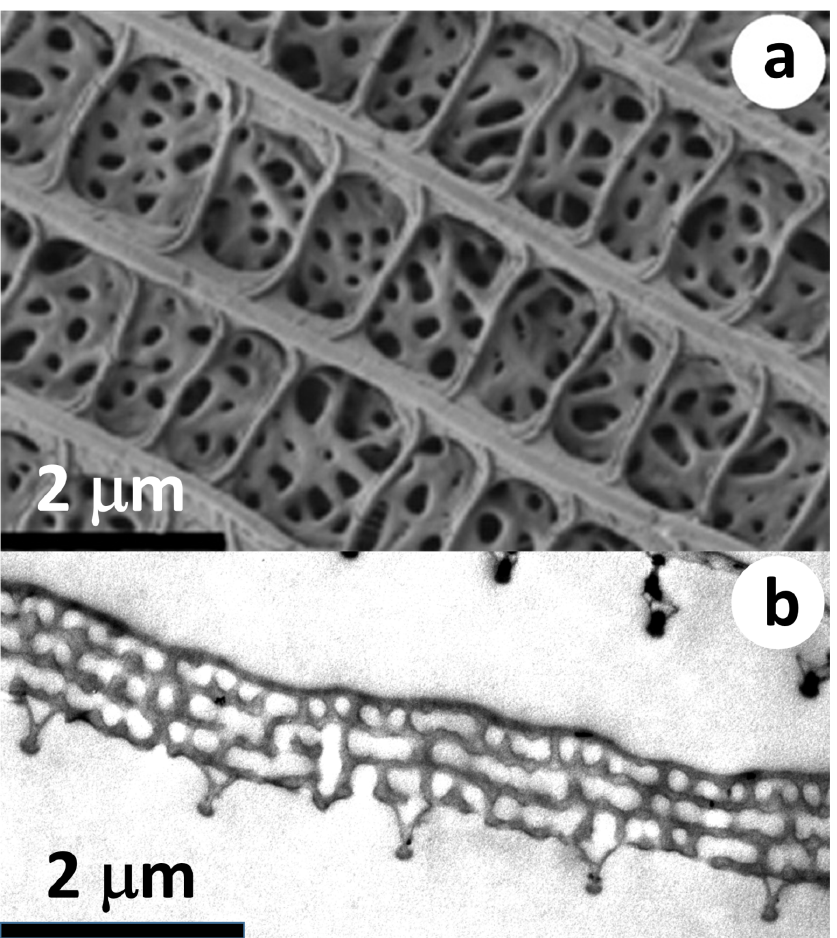
Figure 1. Electron micrographs of the scales on the ventral wing surface of an Albulina metallica male. ( a ) Top view SEM micrograph of a cover scale (from [13]); the dark holes correspond to the air voids. ( b ) Cross-sectional TEM micrograph of a cover scale (from [28]). The light gray regions correspond to the air voids. The five triangular downward protrusions are the cross-sections of the ridges. The scale is displayed facing down, i.e., the ridges are pointing downwards to symbolize that it is a ventral scale. Note the edge of another scale in the upper right corner of the micrograph, which is a ground